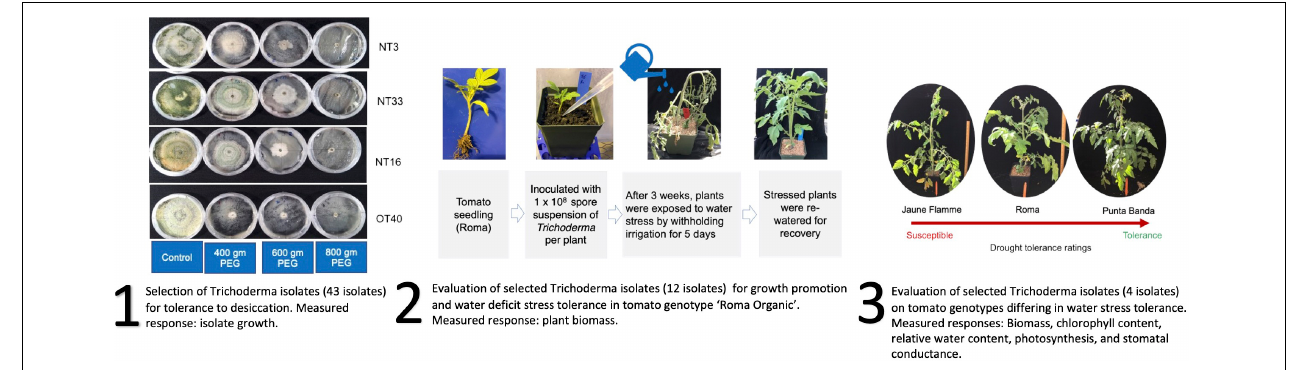
FIGURE 1 | Overview of the replicated experiments reported in this manuscript. First, a collection of isolates from different geographical regions in Nepal were screened for desiccation tolerance. Second, a subset of these isolates was selected to screen for water deficit amelioration in ‘Roma Organic’ tomato. And third, the superior isolates were tested to evaluate Trichoderma × tomato genotype interaction in water deficit stress amelioration. Response variables measured in each set of experiments is included in the